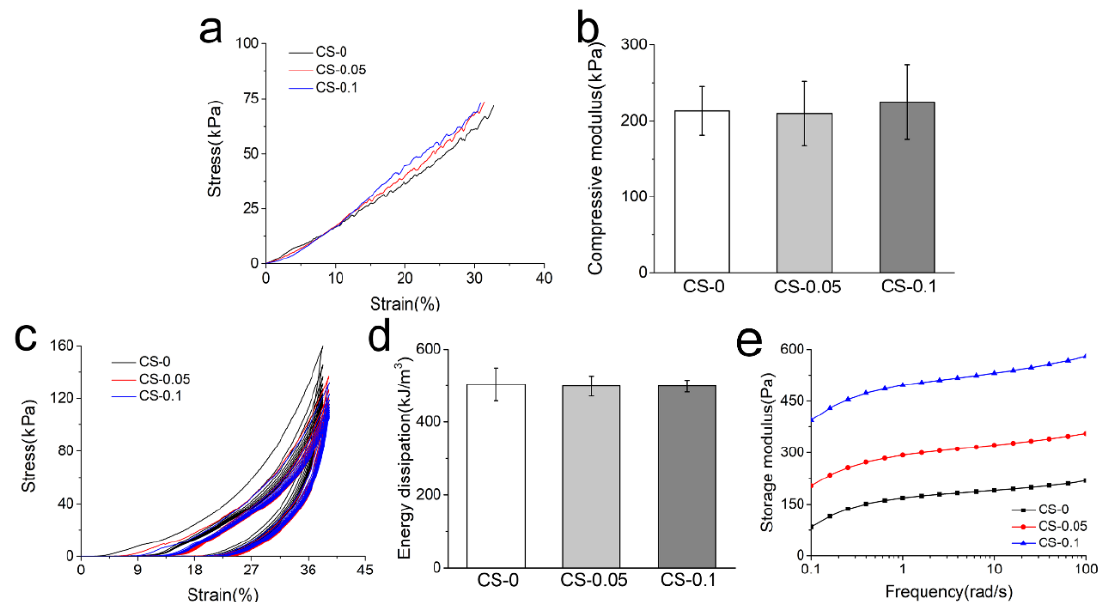
Figure 6. ( a ) The representative compressive stress–strain curves; ( b ) compressive modulus; ( c ) cyclic compressive stress–strain curves; ( d ) energy dissipation during cyclic compression on different hydrogels; and ( e ) storage modulus of each group .